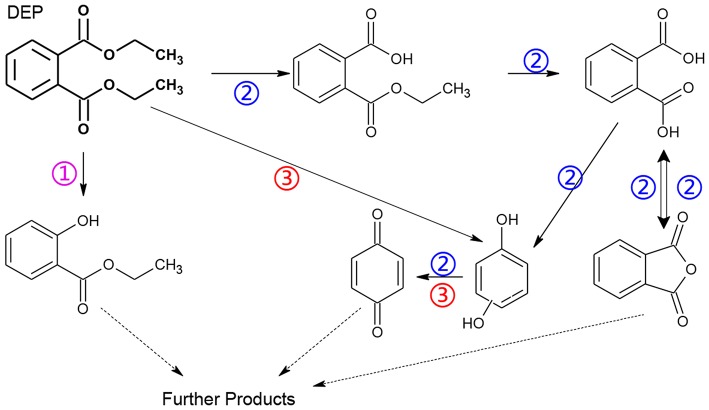
Proposed pathway for DEP degradation in different systems (① UV system; ② UV/TiO2 system; ③ UV-Vis/Bi2WO6 system).